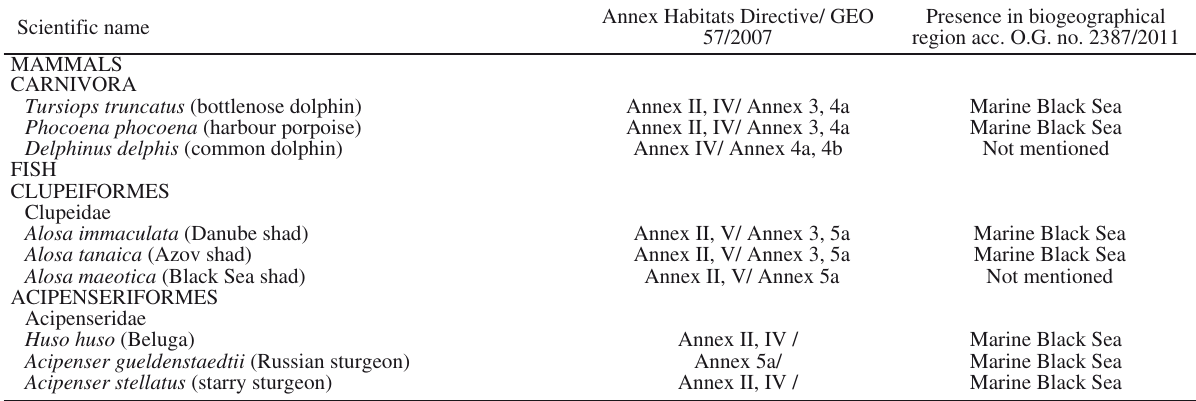
Table 1. – Marine species protected under the Habitats Directive.